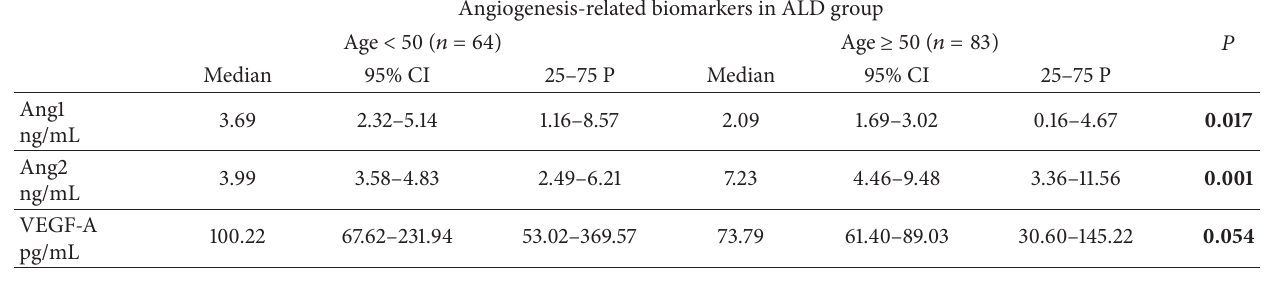
Table 3: Comparison of plasma angiogenic biomarkers according to the age of patients with ALD. Angiogenesis-related biomarkers in ALD group